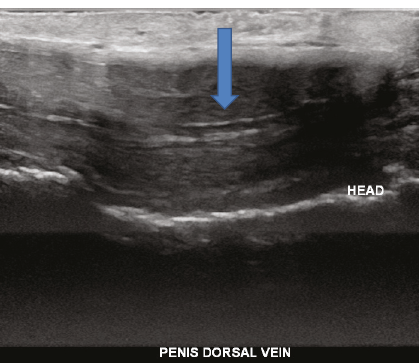
Figure 1: Penile ultrasound with the arrow directed towards thrombus in the dorsal vein. It is noncompressible.